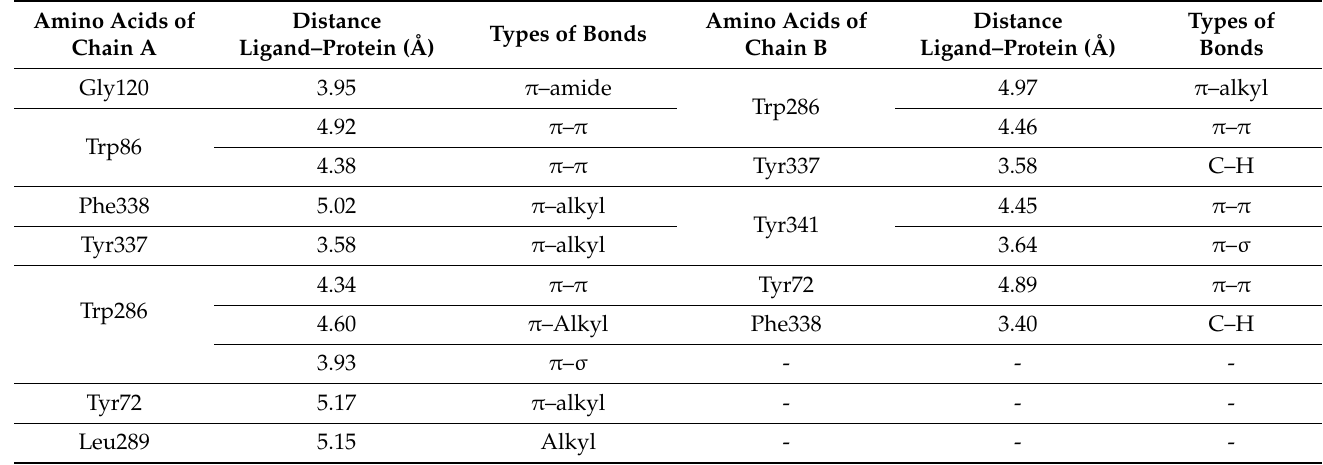
Table 1. Donepezil–AChE ligand–receptor interactions at the A and B